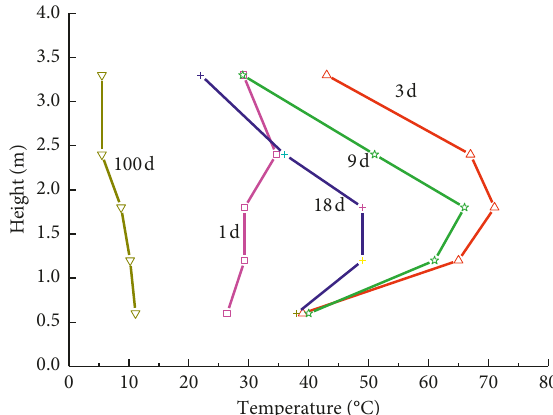
Figure 5: Measured temperature evolution of Points 006–010.